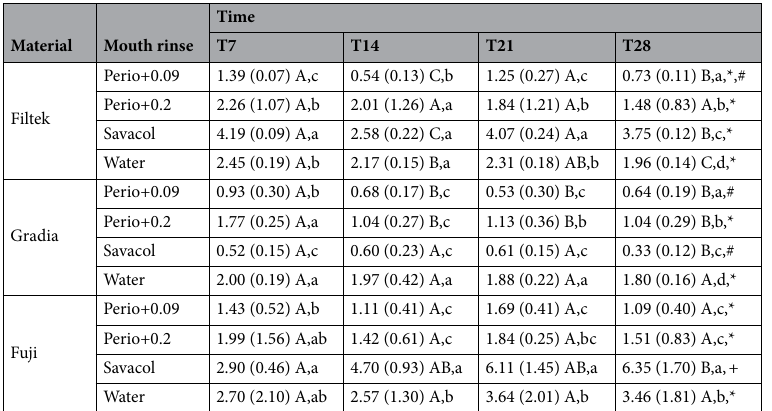
Table 2. Mean (SD) values of colour difference (ΔE 00 ) of the tested materials following exposure to mouth rinses at different time intervals. Upper case letters—rows comparing times within each material-mouth rinse; Lower case letters—columns comparing mouth rinses within each material-time; Symbols—columns comparing materials at T28 within each mouth rinse.